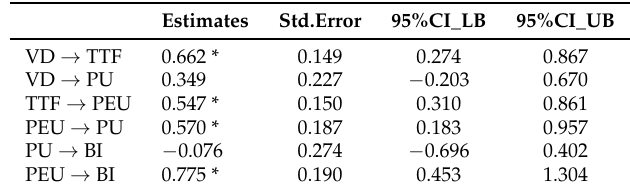
Table 9. Estimates of path coefficients.